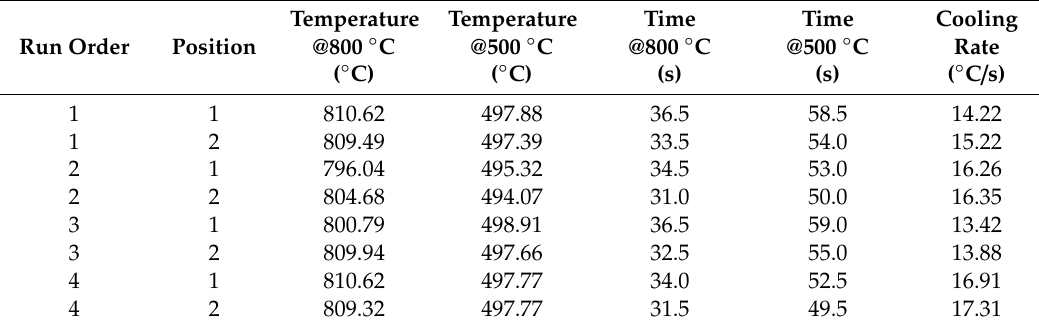
Table 6. Cooling rate calculation at position 1 and position 2.